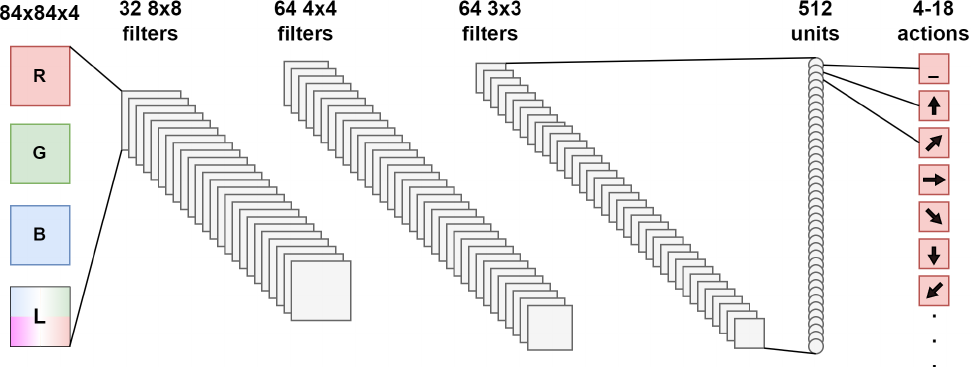
Figure 5. ATARI deep Q–network architecture based on DeepMind’s 2015 publication in Nature